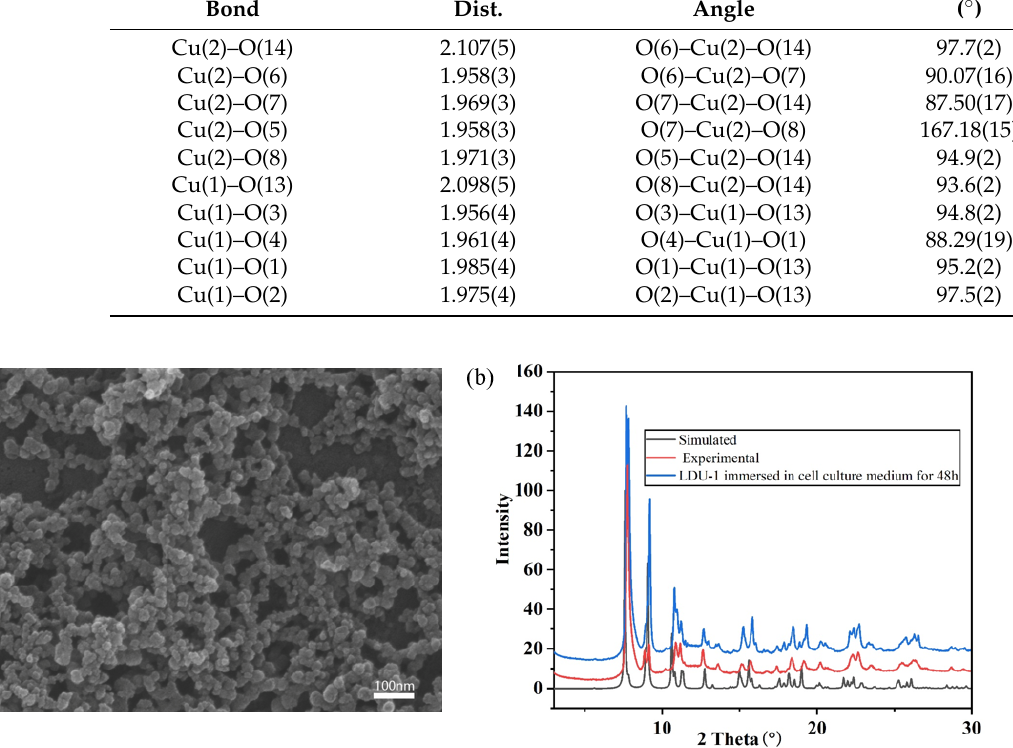
Figure 3. ( a ) SEM image of LDU-1. ( b ) XRD patterns of LDU-1, as-synthesized and immersed in cell culture medium for 48 h, respectively.